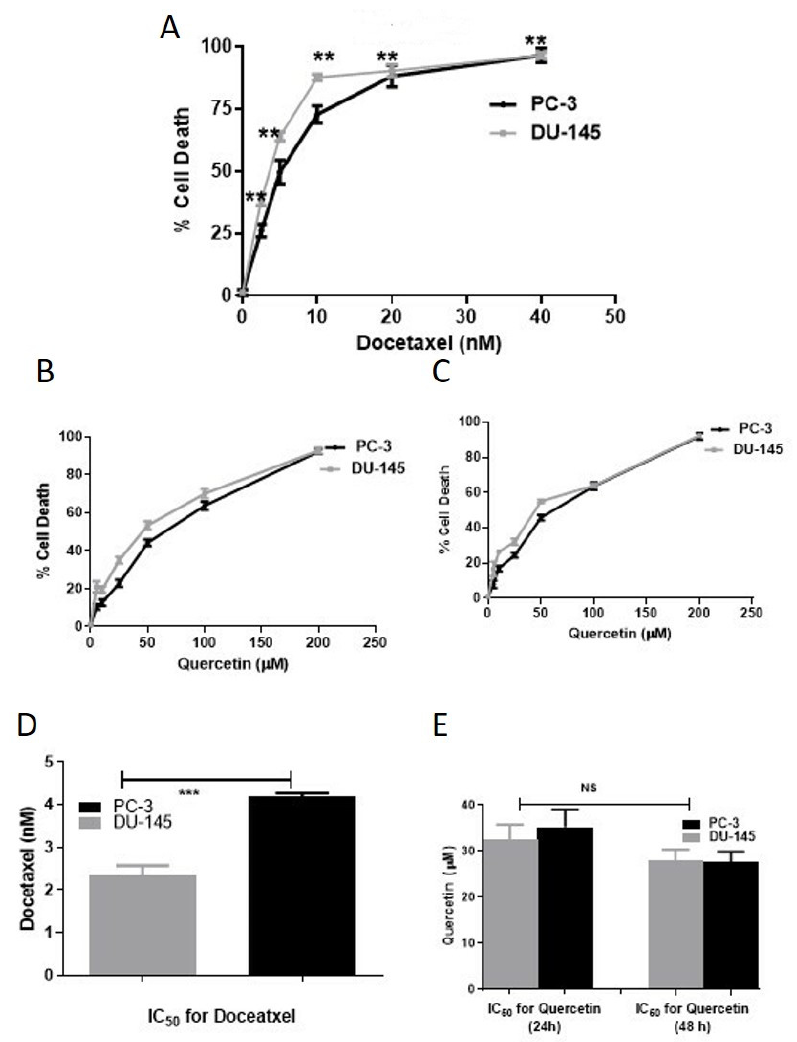
Figure 1. Cytotoxicity of docetaxel and quercetin on DU-145 (moderately aggressive) and PC-3 (very aggressive) human prostate cancer cells. The cells were treated with the indicated concentrations of docetaxel for 24 h and with quercetin for 24 and 48 h. ( A ) DU-145 and PC-3 cells treated with docetaxel (0.5–40 nM). ** p < 0.01. ( B ) DU-145 and PC-3 cells treated with quercetin (1.0–100 µ M) for 24 h. ( C ) DU-145 and PC-3 cells treated with quercetin (1.0–100 µ M) for 48 h. Cytotoxicity was evaluated by MTT assay. The data represent the mean ± SD of three experiments performed in triplicate. ( D ) A comparison of IC 50 values obtained for DU-145 and PC-3 cells treated with docetaxel for 24 h. ( E ) A comparison of IC 50 values obtained for DU-145 and PC-3 with quercetin for 48 h. ***: t -test p < 0.001 between IC 50 values obtained for the same drug in the same period and “NS” is